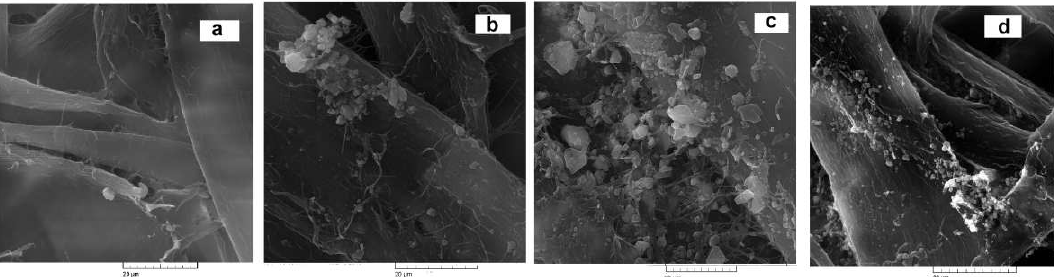
Figure 5. SEM images of paper samples: without PCC ( a ), 35% PCC ( b ), 35% PCC/1% polyDADMAC ( c ) and 35% PCC/0.1% cPAM ( d ).